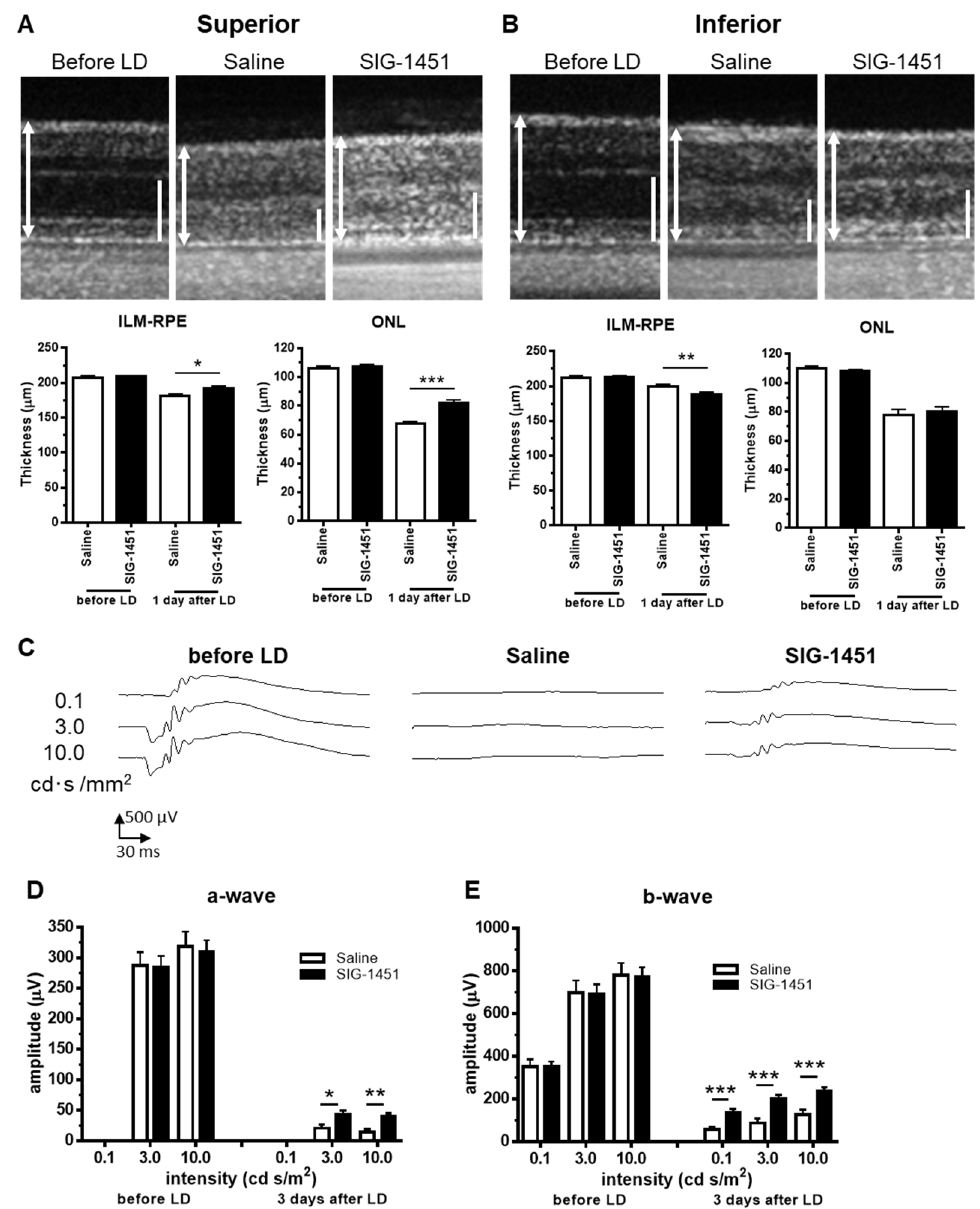
Figure 1. Effects of SIG-1451 on retinal thickness and electroretinographic responses in light-induced photoreceptor degeneration. OCT images of the superior ( A ) and inferior part ( B ) of retinas were obtained 1 d after the end of light exposure, and the thicknesses of the inner limiting membrane (ILM) to the retinal pigment epithelium (RPE) and the outer nuclear layer (ONL), including outer segments, were measured. ILM-RPE and the ONL are indicated by a double-headed arrow (L) and bar (R), respectively. Typical waveforms of ERGs are shown in ( C ). The amplitudes of a-waves ( D ) and b-waves ( E ) were measured. Data are represented in terms of the mean ± SEM values (saline: n = 14, SIG-1451: n = 16, unpaired t -test; *, **, *** p < 0.05, 0.01,